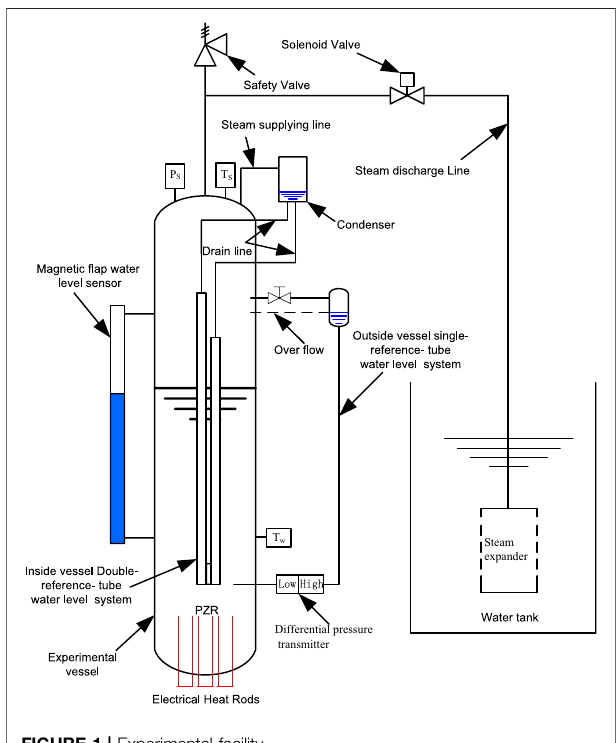
FIGURE 1 | Experimental facility.